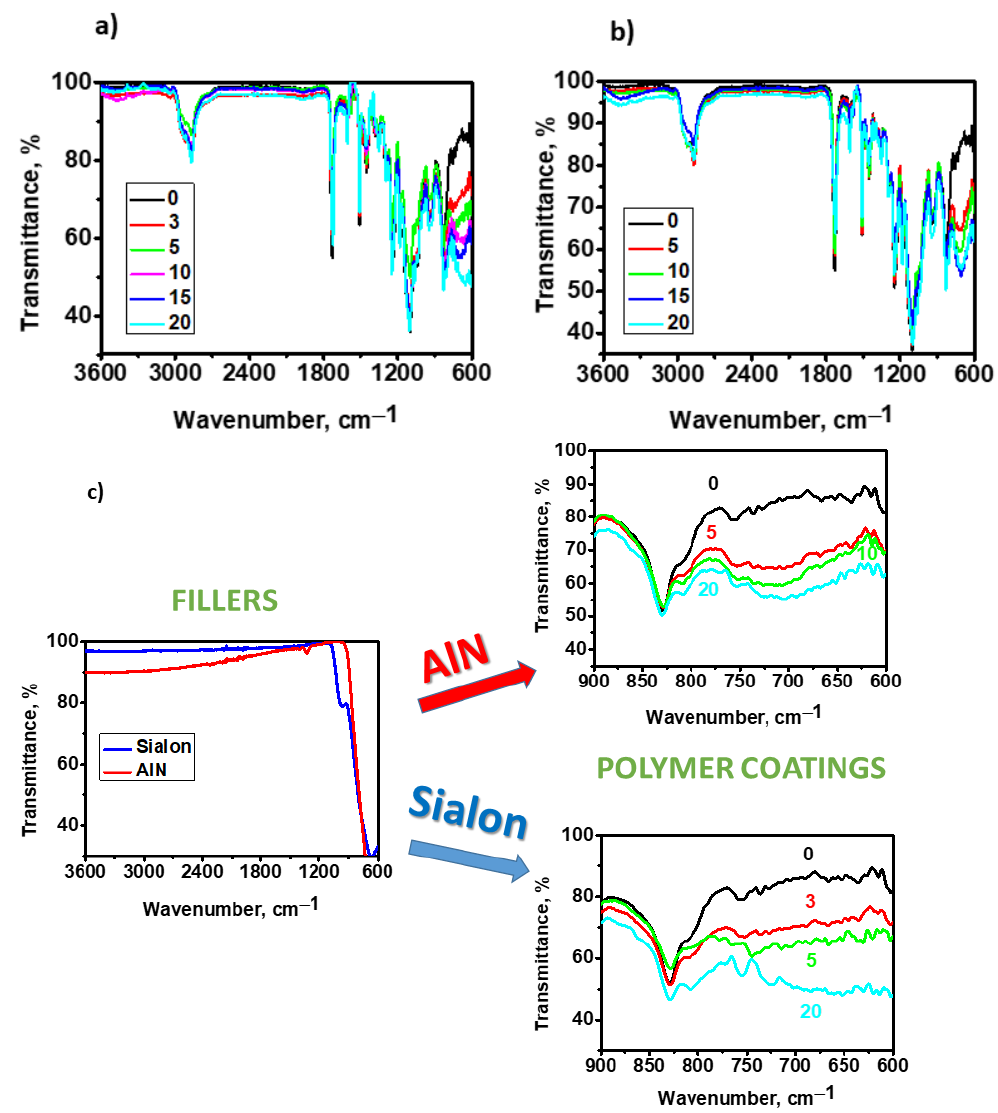
Figure 6. FTIR-ATR spectra of neat matrix and coatings containing ( a ) Sialon; ( b ) AlN and spectra of neat fillers and coatings ( c ). The numbers indicate filler content in wt.%.